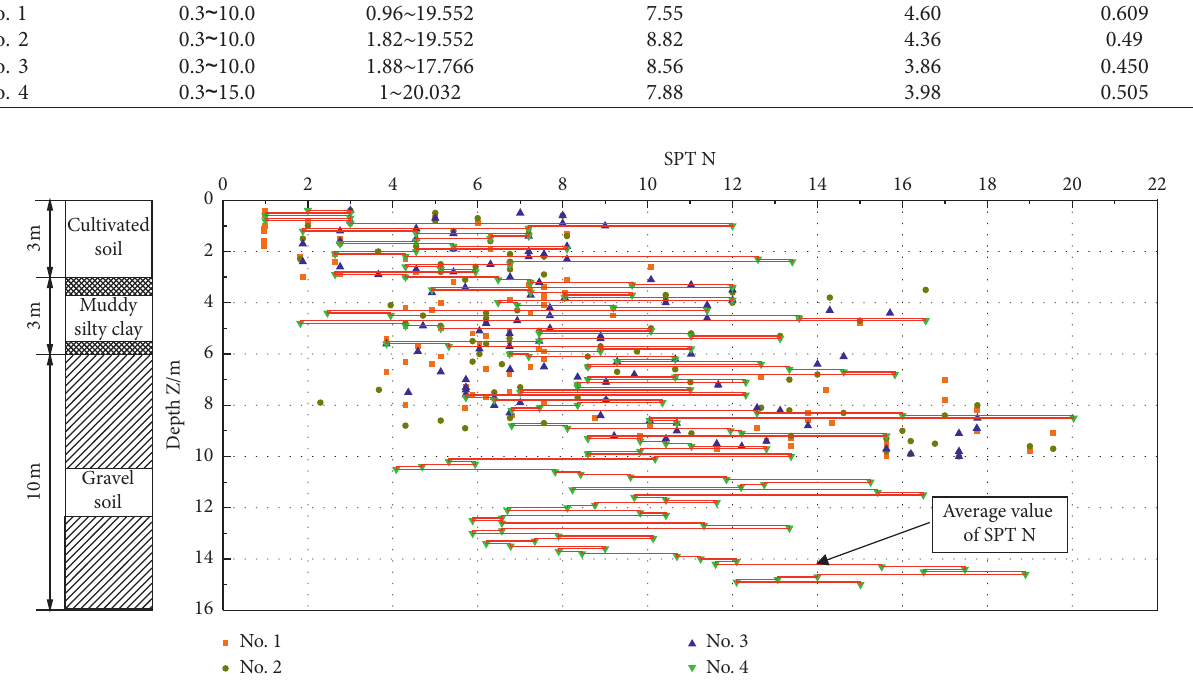
Figure 2: SPT N 120 values with depth. Table 2: Statistics and analysis of gravel soil screening test and conventional physical